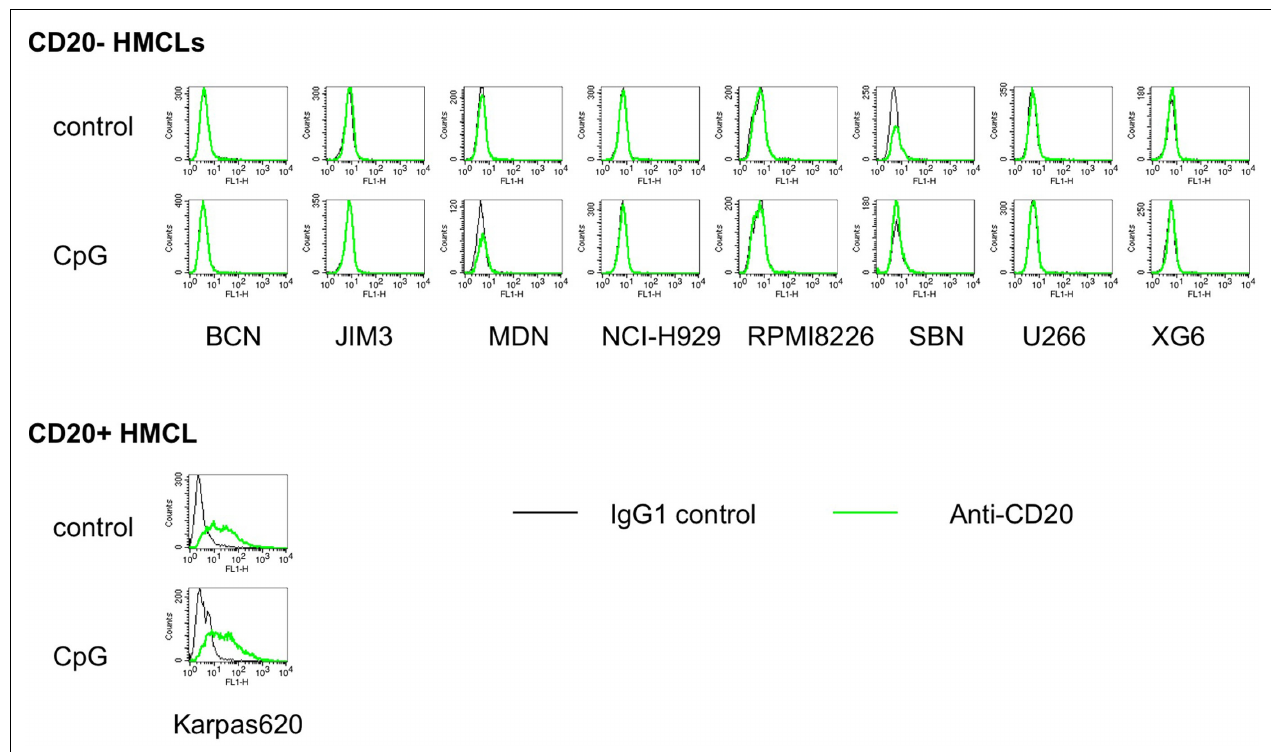
FIGURE 5 | CpG ODN neither induce nor increase CD20 expression on myeloma cell lines. Nine multiple myeloma cell lines expressingTLR9 were cultured for 2days with or without CpG2006, and CD20 expression was analyzed by flow cytometry. Overlay histograms represent the CD20 staining over the control